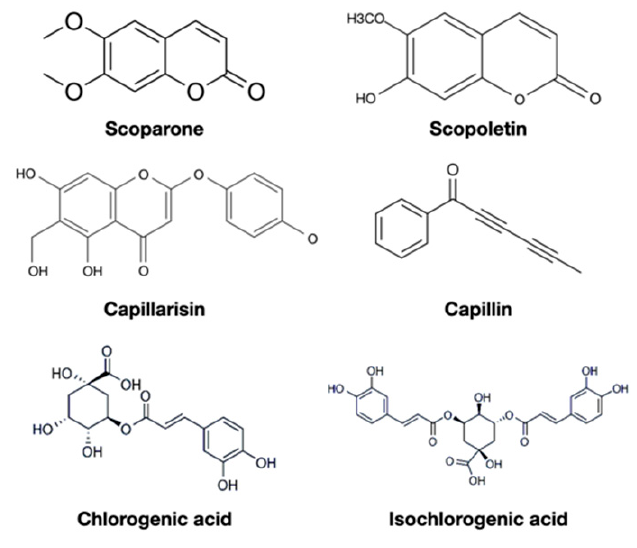
Figure 1. The chemical structure of commonly identified constituents in Artemisia capillaris .